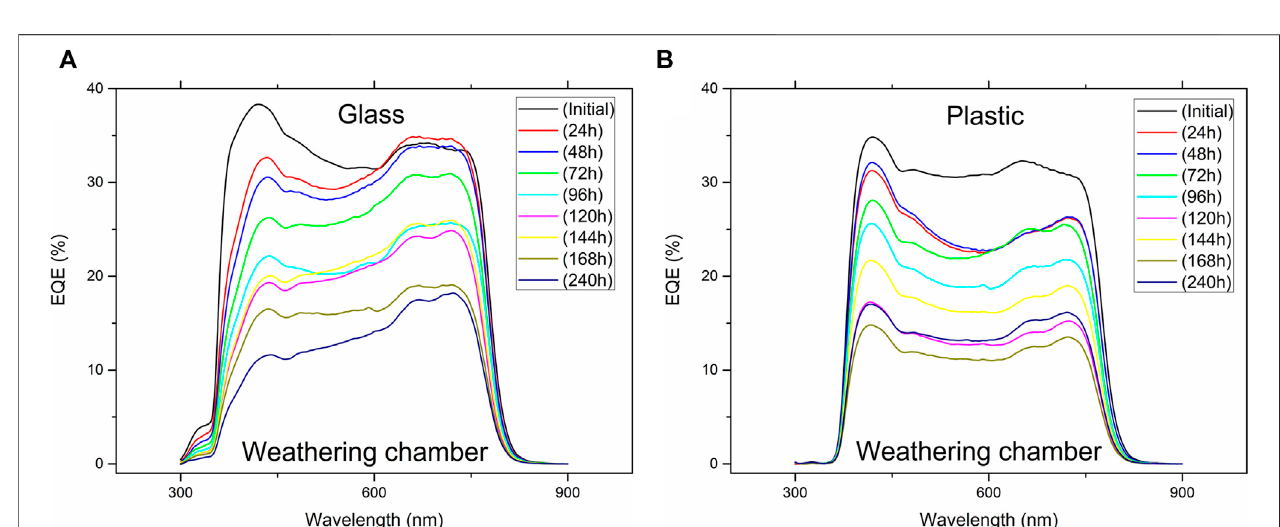
FIGURE 6 | Evolution of the EQE vs. time for ISOS-LT-1 for both encapsulations (glass (A) and plastic (B) , respectively).